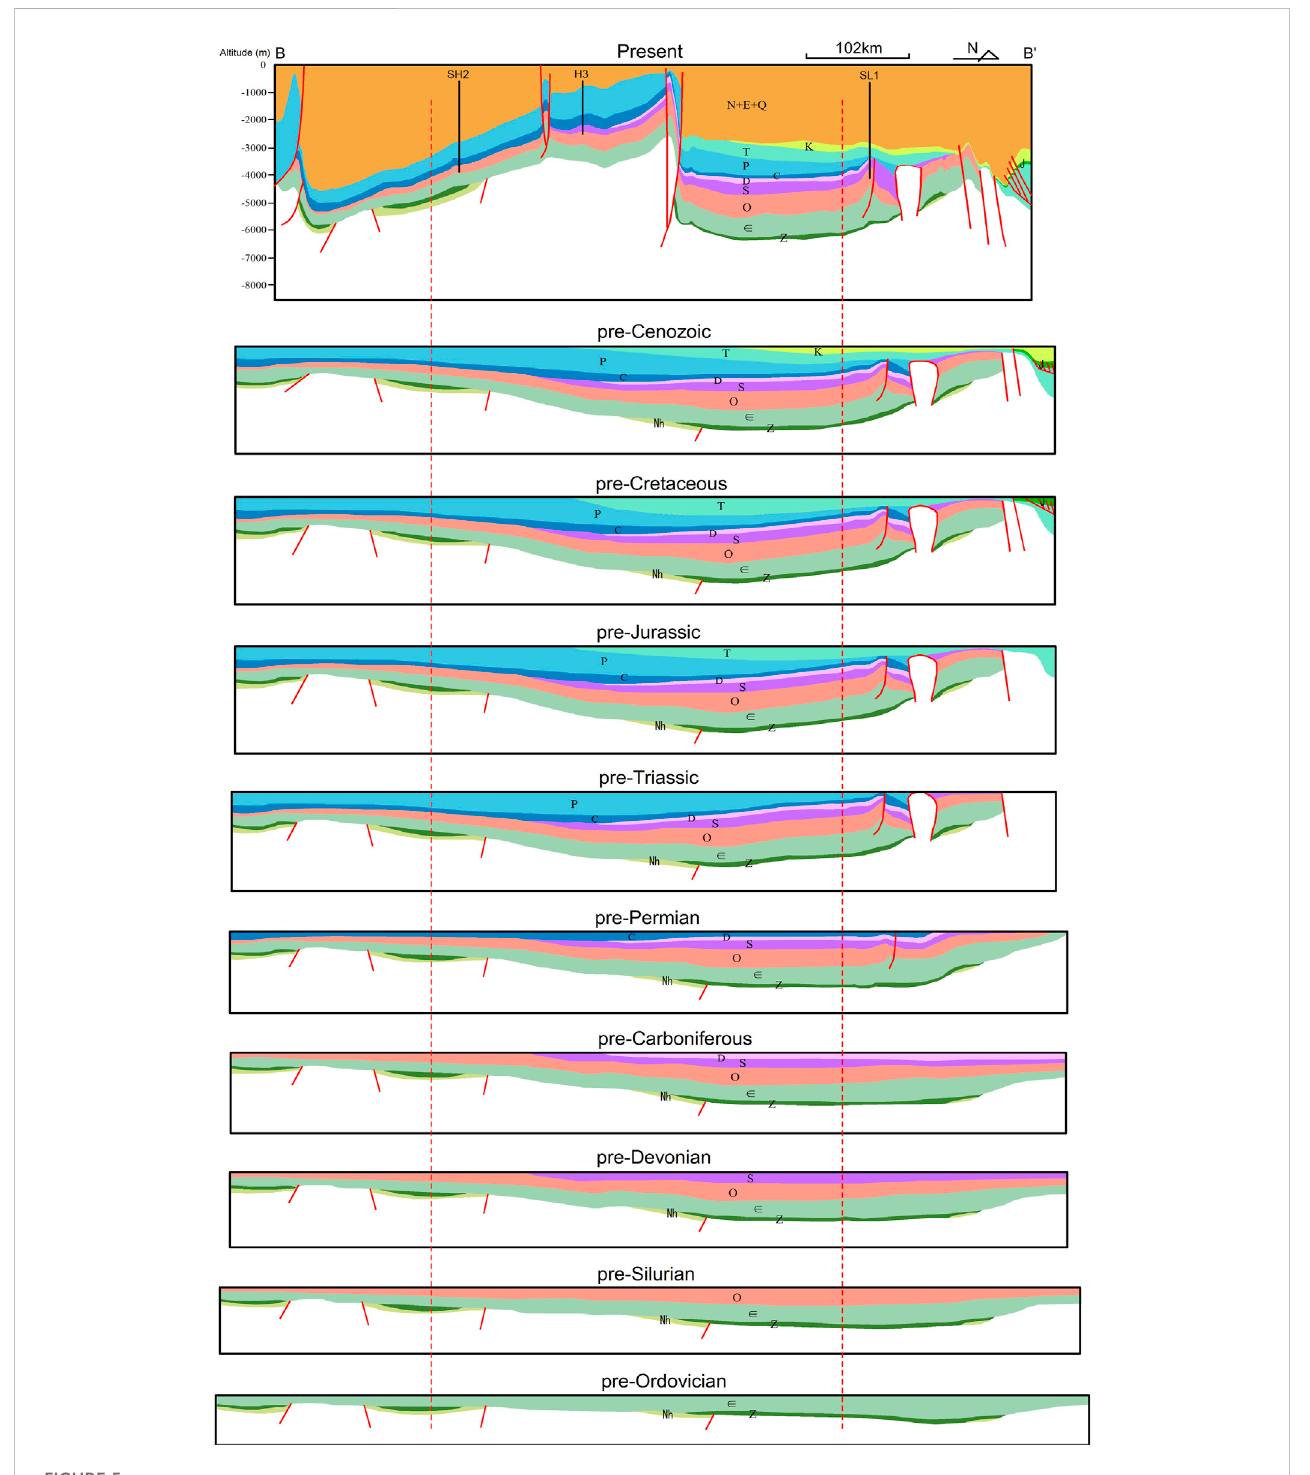
FIGURE 5 Recovered balanced cross-sectionof BB ’ . The location of thisseismic section is shown inFigure 1B.The red dotted lines visually represent theboundary between the margin and the interior of the Tarim Basin.